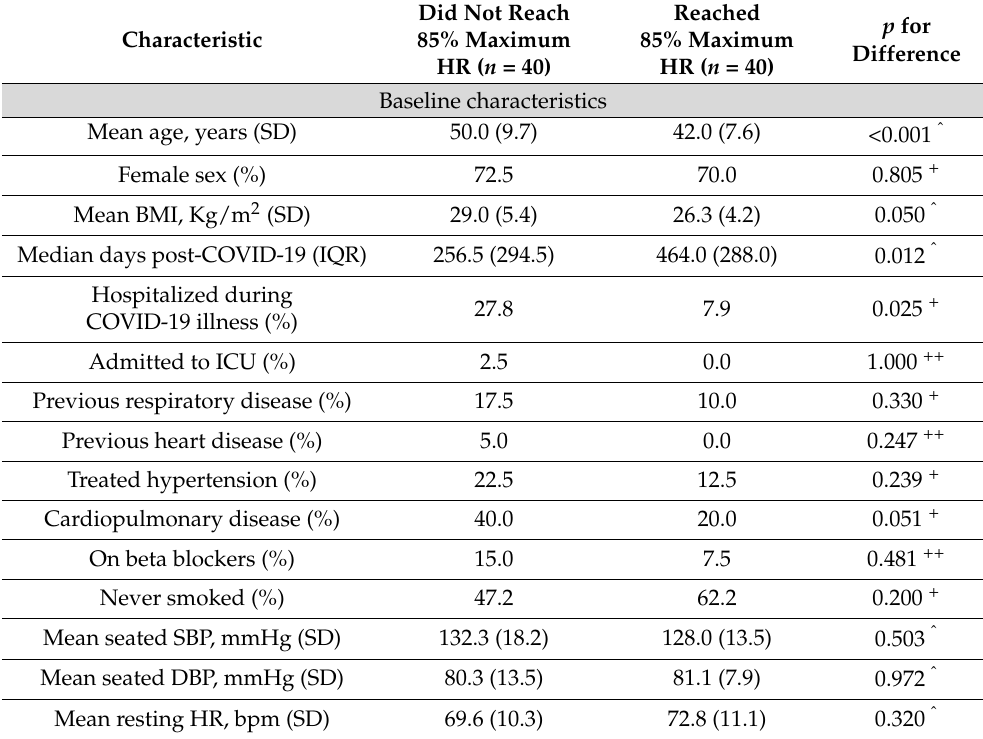
Table 1. Participant characteristics by achievement of 85% maximum predicted heart